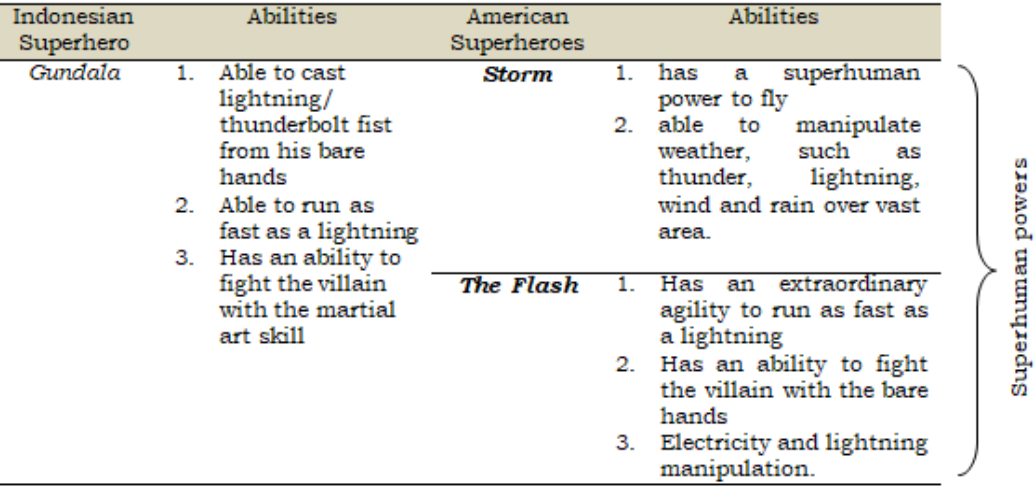
Table 2. Characters powers similarity between Indonesian superheroes and American